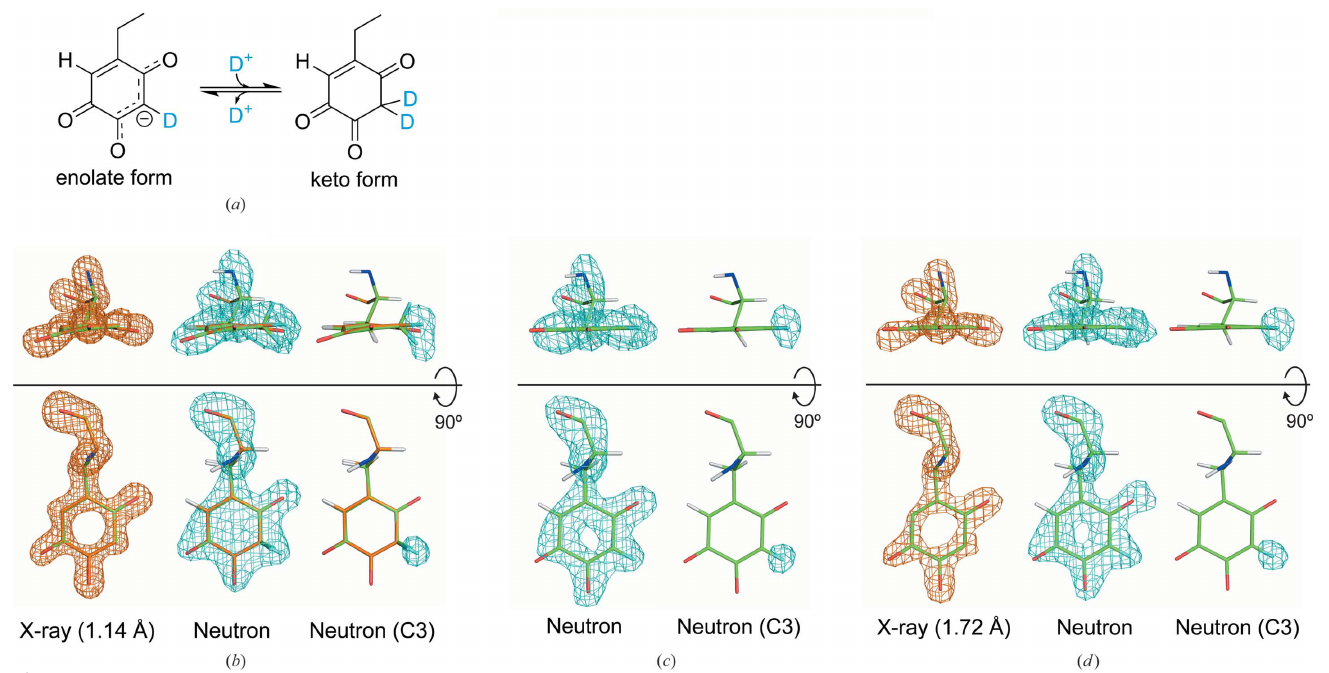
Figure 2 Quinone cofactor structure refined with various data sets. ( a ) Equilibrium between the enolate and the keto forms of TPQ. Refined structure of TPQ from ( b ) X-ray/neutron analysis, ( c ) neutron analysis and ( d ) X-ray (1.72 A˚ )/neutron analysis. The assigned model of TPQ is superimposed on the F o – F c polder omit ED map [orange mesh, contoured at 7.0 (cid:5) for residue 382 (TPQ) in ( b ) and ( d )] or on the F o – F c polder omit SLD map [cyan mesh, contoured at 4.0 (cid:5) for residue 382 and at 3.5 (cid:5) for D atom(s) attached to the C3 atom of residue 382 in ( b ), ( c ) and ( d